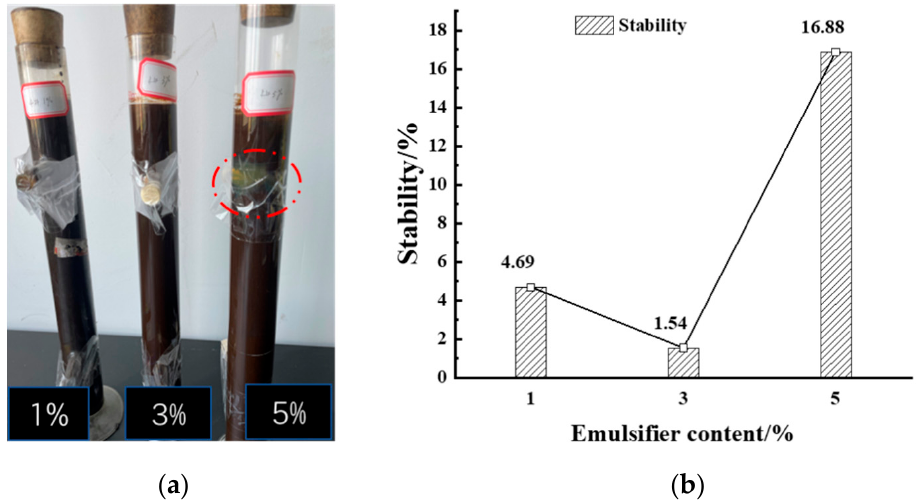
Figure 9. Effect of emulsifier dosing on the storage stability performance of biomass asphalt/water emulsion. ( a ) Flocculation of Asphalt/water emulsion. ( b ) Stability.